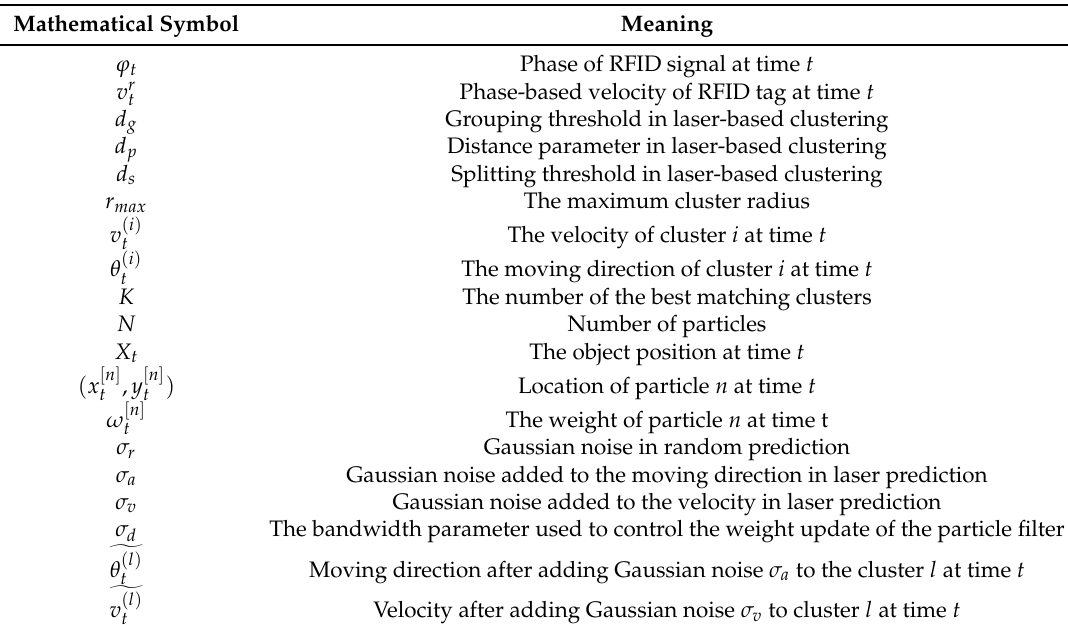
Table 1. Mathematical symbols and their